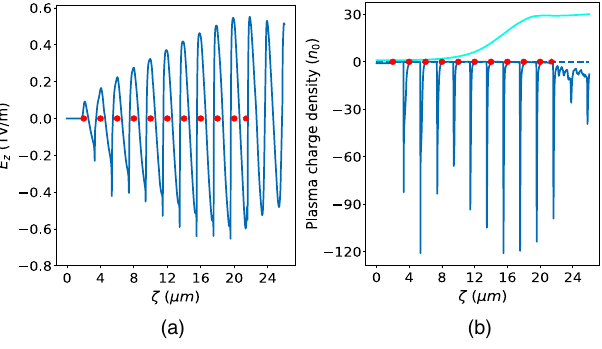
FIG. 2. The axial longitudinal electric field (a), plasma electron (dark blue) and ion (light blue) density (b) when using ten driver bunches (circle) (charge per driver bunch ¼ 0 . 32 pC) and a witness bunch. Each bunch is separated by λ p and has an initial transverse spot size of 13 nm.